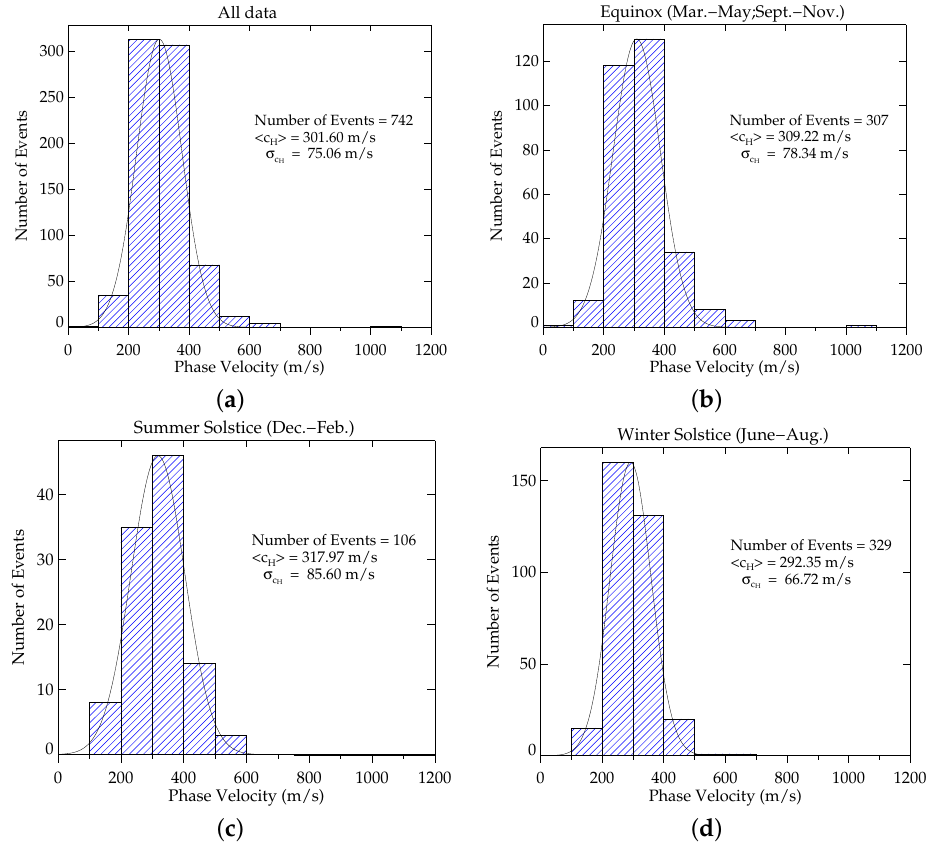
Figure 9. The horizontal phase velocity distribution of the observed medium-scale traveling iono- spheric disturbances for ( a ) all seasons, ( b ) equinoxes, ( c ) summer, and ( d )